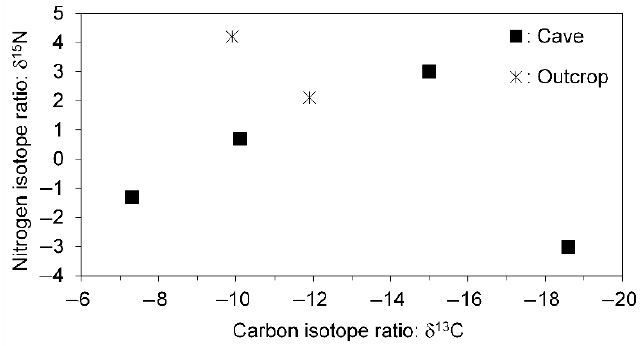
Figure 8. Carbon and nitrogen stable isotope ratios of the stalactite minerals.